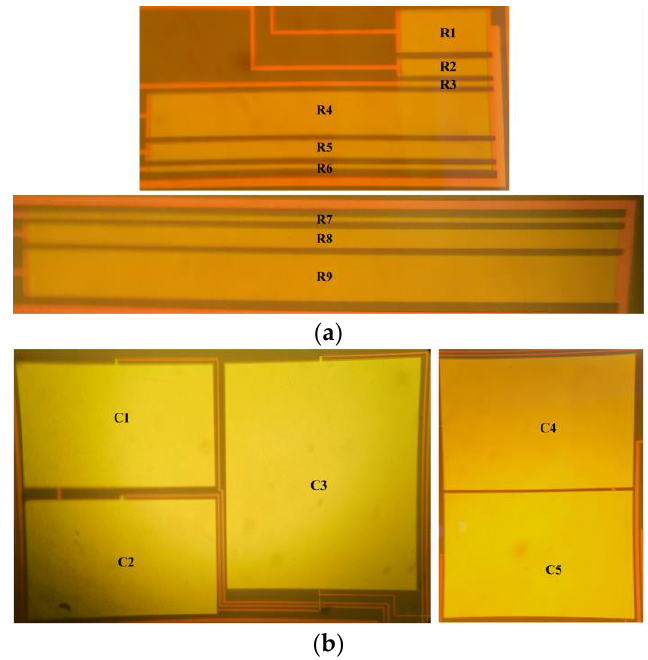
Figure 4. Integrated passive components for HT characterization: ( a ) Resistors; ( b ) Capacitors. Table 1. Integrated Resistors and Capacitors.